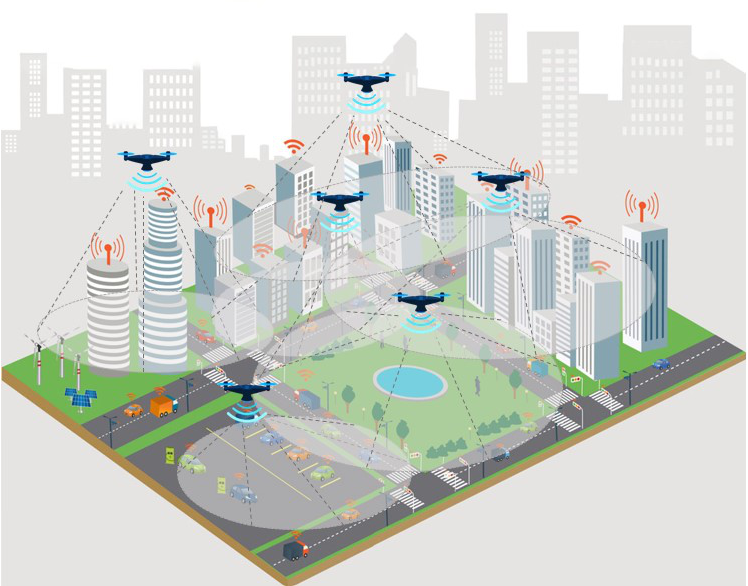
Figure 1. Smart City